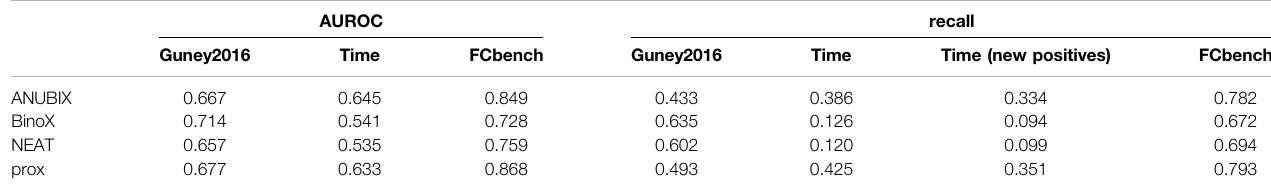
TABLE 1 | Performance metrics for all three benchmarks. Performance on the three benchmarks, Guney 2016, time-stamped (time), and FCbench, was assessed for different drug repurposing tools: ANUBIX, BinoX, NEAT, and proximity (prox). The evaluated metricsinclude AUROC, recall, and recall on the pairs with changed label in the time-stamped benchmark (new positives).